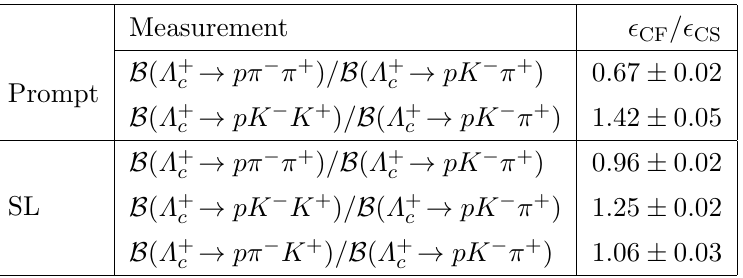
Table 1 . Selection e(cid:14)ciency ratios in the prompt and SL measurements, with their associated systematic uncertainties. (cid:15) CF =(cid:15) CS denotes the ratio of the Cabibbo-favoured selection e(cid:14)ciency over that of the Cabibbo-suppressed